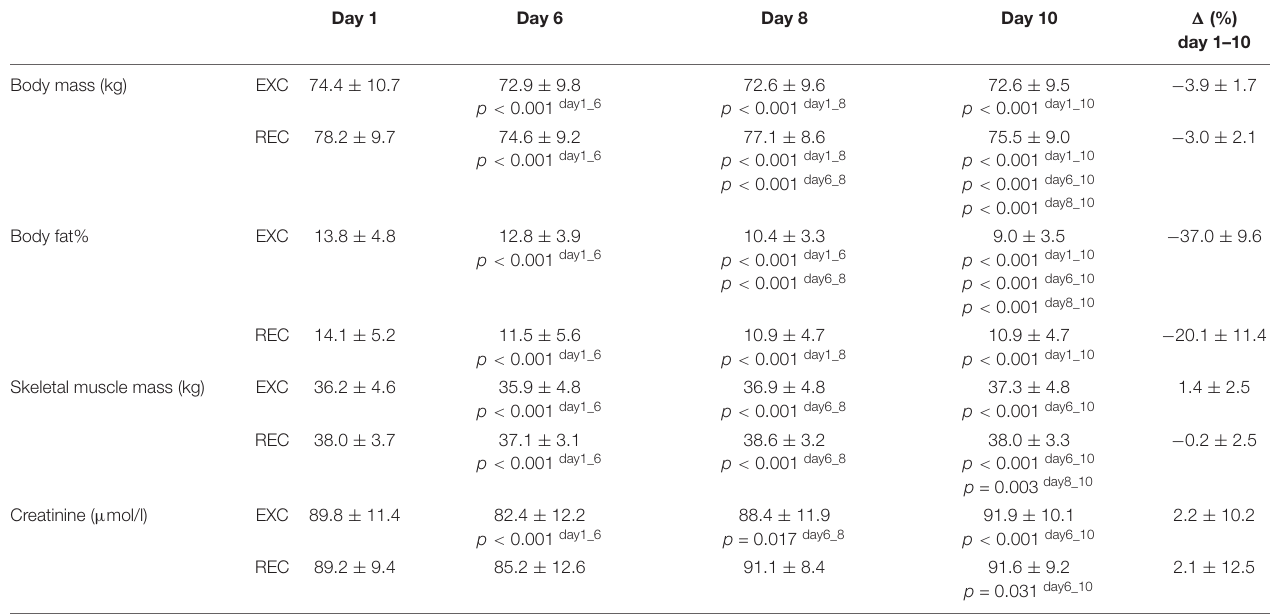
TABLE 3 | Changes in body mass, body fat%, skeletal muscle mass and serum creatinine during the training